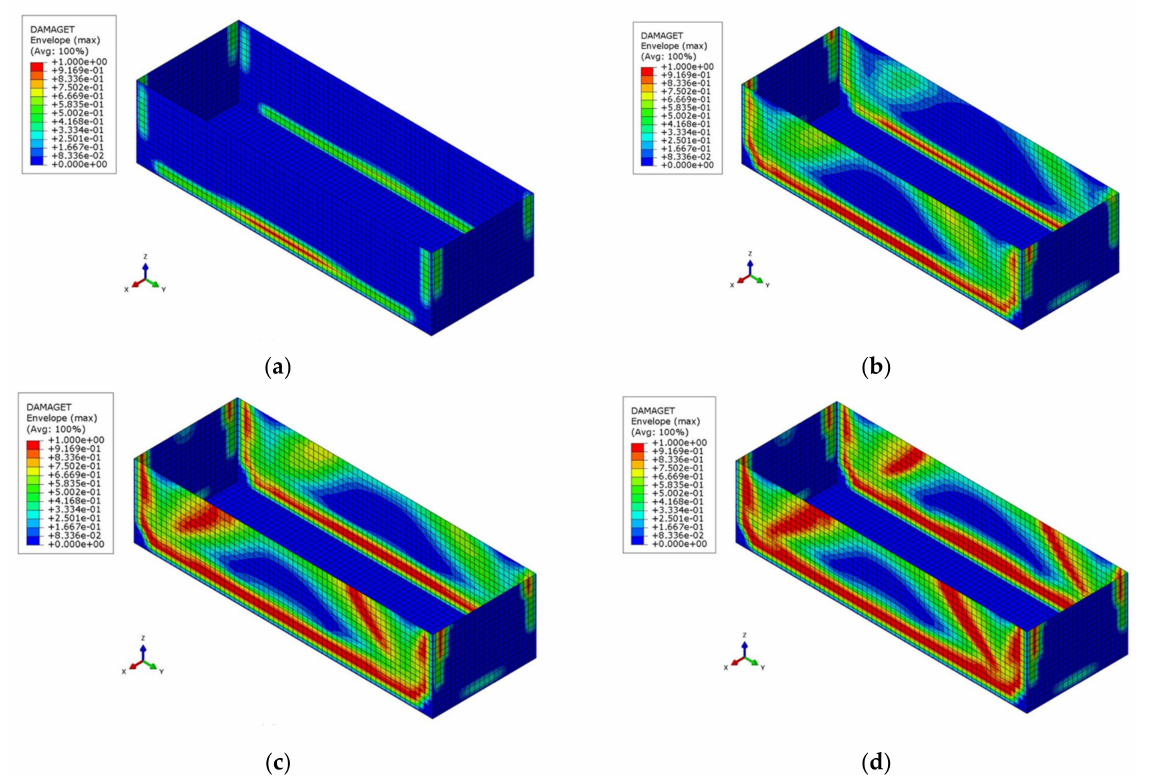
Figure 16. Tensile damage variable d t when the incident angle of the input ground motion is 50 ◦ : ( a ) 1.46 s; ( b ) 2.37 s; ( c ) 2.69 s; ( d ) 12.23 s.